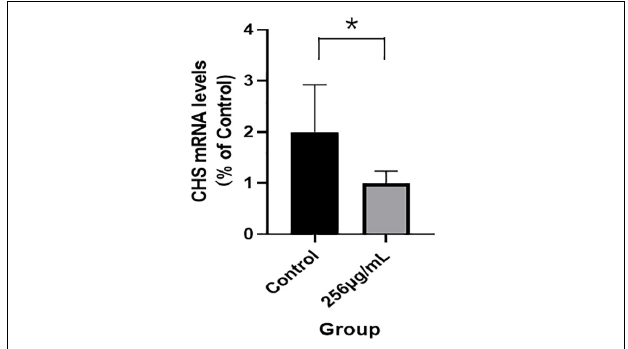
FIGURE 7 | The mRNA expression levels of chitin synthase detected by qRT-PCR (* P < 0.05).